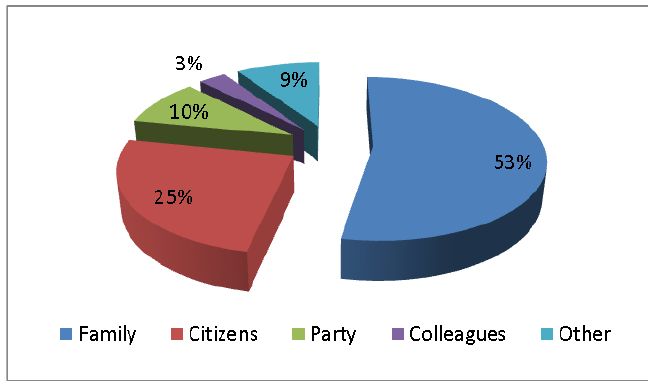
Figure 3: Who supported your candidacy? Data source: The interview